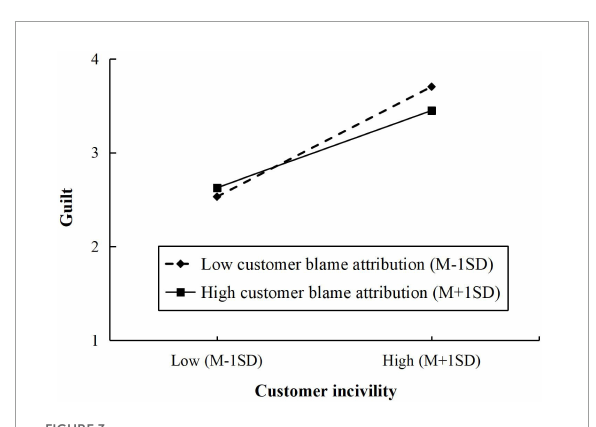
FIGURE3 The moderating effect of customer blame attribution on the relationship between customer incivility and